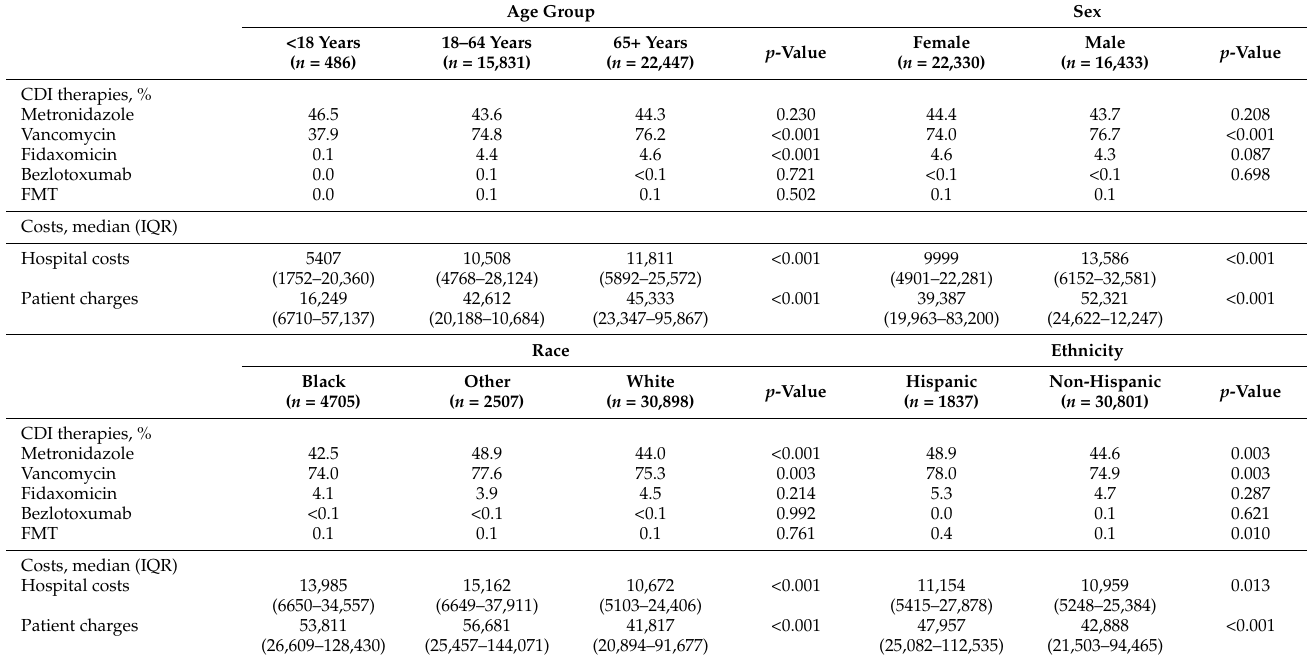
Table 2. CDI treatment patterns by patient subgroups for index